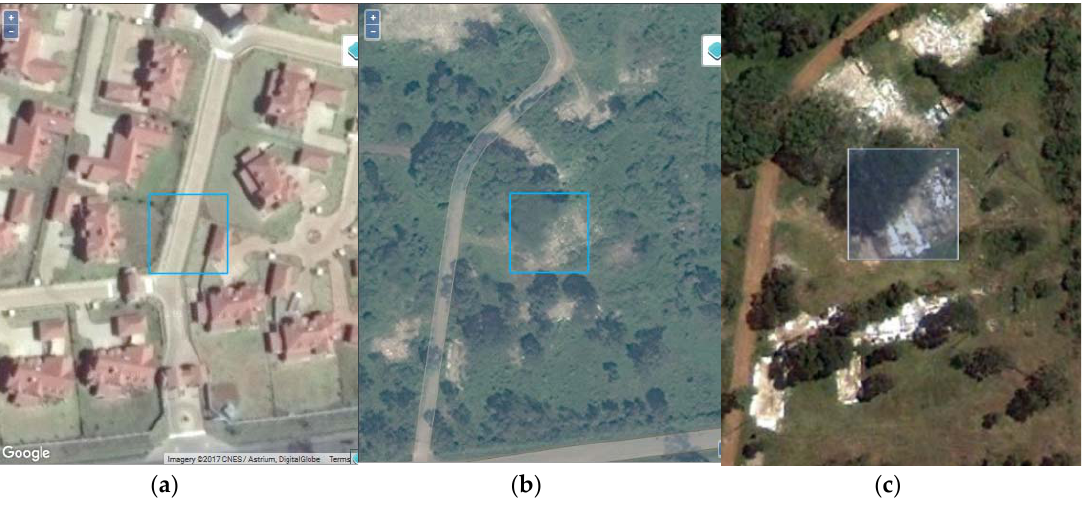
Figure 13. Imagery from: ( a ) Google Maps in LACO-Wiki for 2017; ( b ) Bing in LACO-Wiki for 2012; and ( c ) Google Earth for 2010.